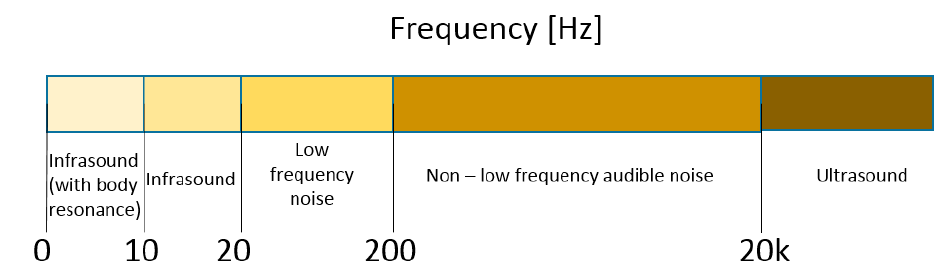
Figure 2. The frequency spectrum of sound and its nomenclature.